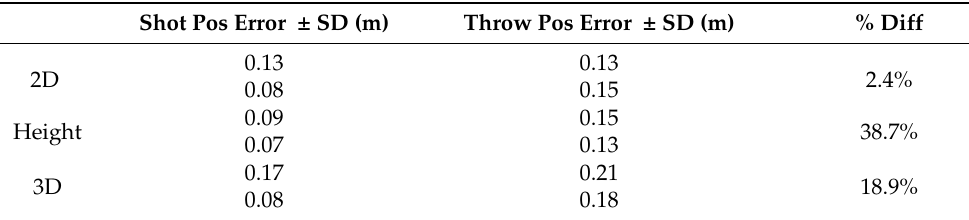
Table 4. Football shot and handball throw: Deviation of impact position at the goal. The percentage difference states the deviation between shot and throw errors.